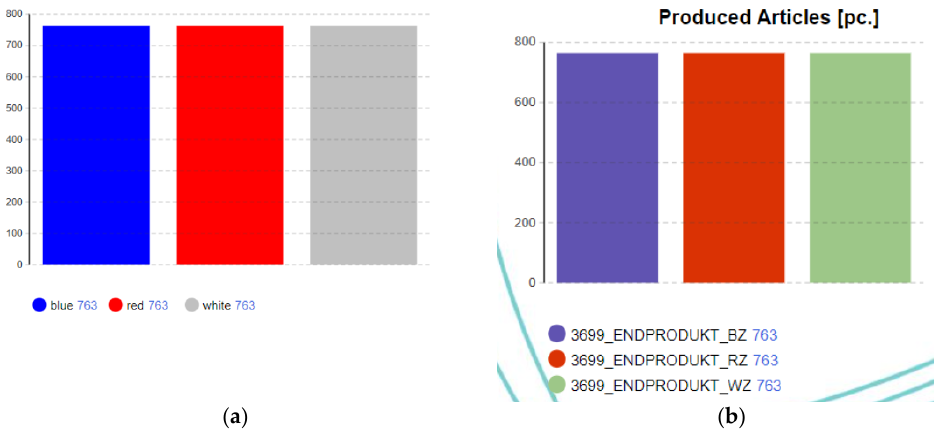
Figure 9. Comparison of the number of pieces produced after 105 hours at ( a ) the non-generic simulation and ( b ) the generic simulation.